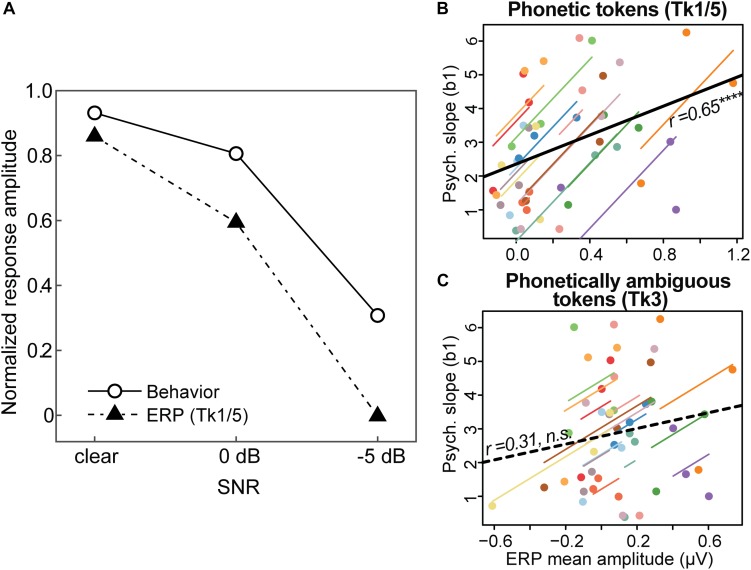
Brain-behavior associations in categorical speech perception. (A) Amplitudes of the auditory ERPs (Figure 5B) are overlaid with behavioral data (psychometric slopes; Figure 3B). Neural and behavioral measures are normalized for each participant (Alain et al., 2001), with 1.0 reflecting the largest displacement in ERP amplitude (mean: 180–320 ms; see Figure 5B) and psychometric slopes, respectively. (B,C) Repeated measures correlations (rmCorr) (Bakdash and Marusich, 2017) between behavioral CP and neural responses at the single-subject level for (B) phonetic (Tk1/5) and (C) phonetically ambiguous speech tokens (Tk3). The ordinate measure represents each listeners’ psychometric slope, computed from their entire identification curve (i.e., Figure 3B). Behavioral CP is predicted only by neural activity to phonetic tokens; larger ERP amplitudes elicited by Tk1/5 speech are associated with steeper, more dichotomous CP. Individual lines, single subject fits; thick black lines, overall rmCorr. ****p < 0.0001.